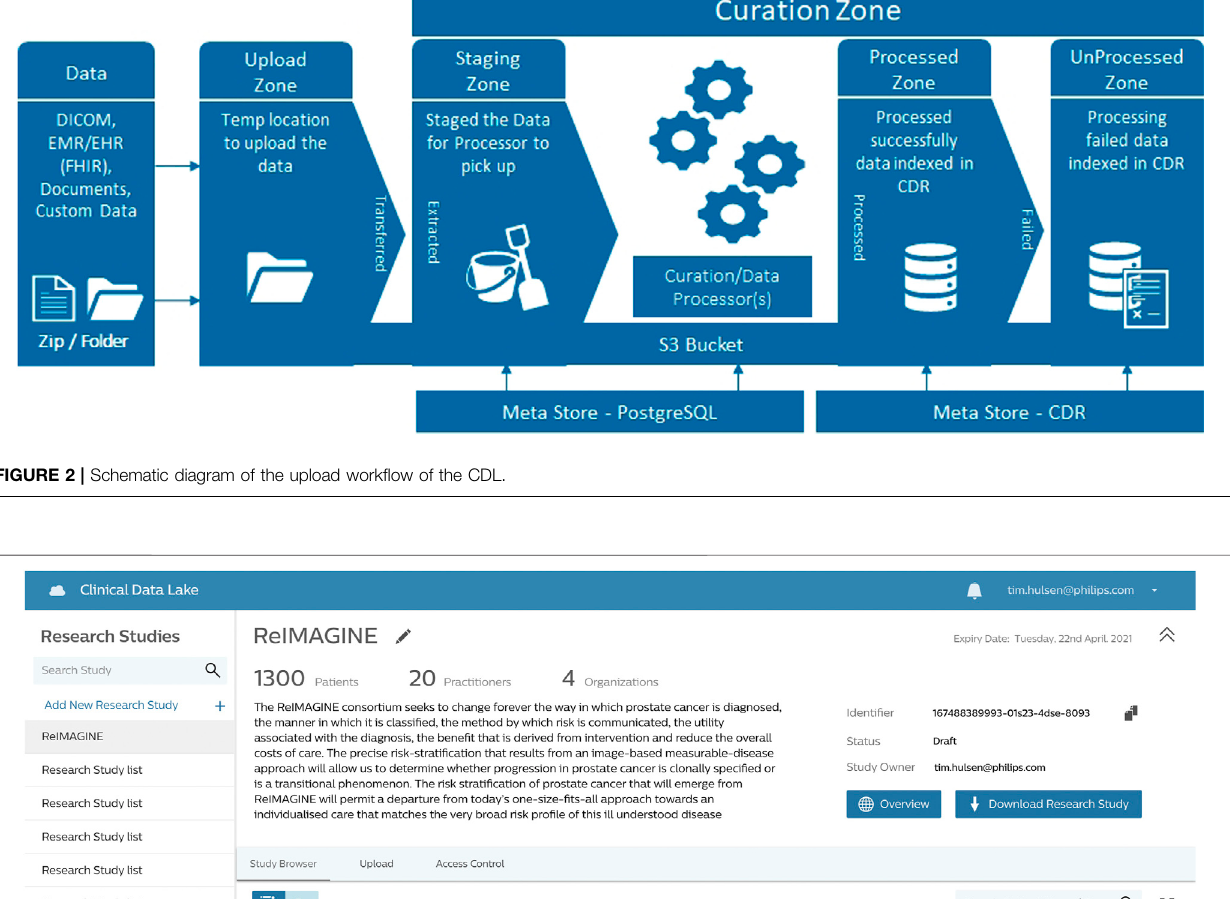
separately with the metadata “ WS1 ” or “ WS2 ” to keep the data separated. Data is organized according to the functionality of the Clinical Data Lake: DICOM (as well as FHIR) data can be processed automatically and is thus uploaded separately from clinical data and genomics data, which need custom data types. Each data item is connected to a subject ID: in DICOM fi les, this is DICOM tag 0010.0020; in other fi les there is a fi eld names ‘ subject ID ’ which contains the